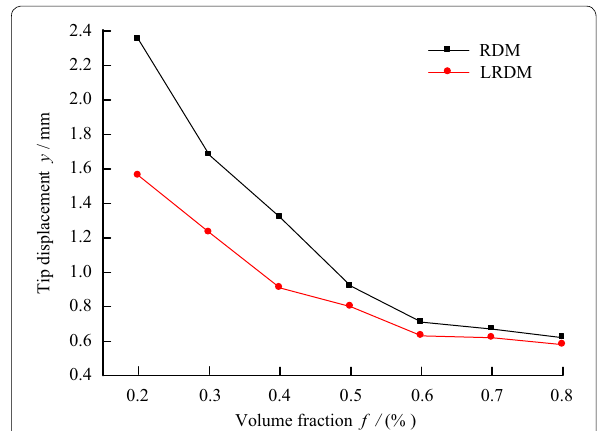
Figure 8 Comparison of tip displacement of generated lattice structure for various volume